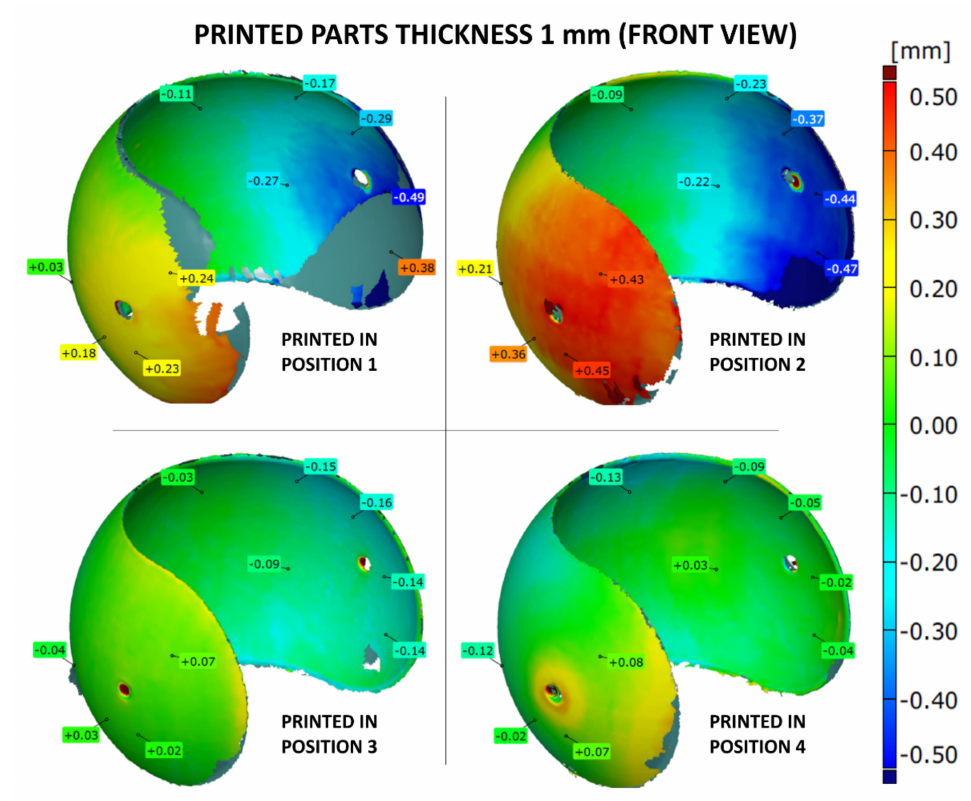
Figure 7. Geometry deviations of 3D printed part with a thickness of 1 mm (front